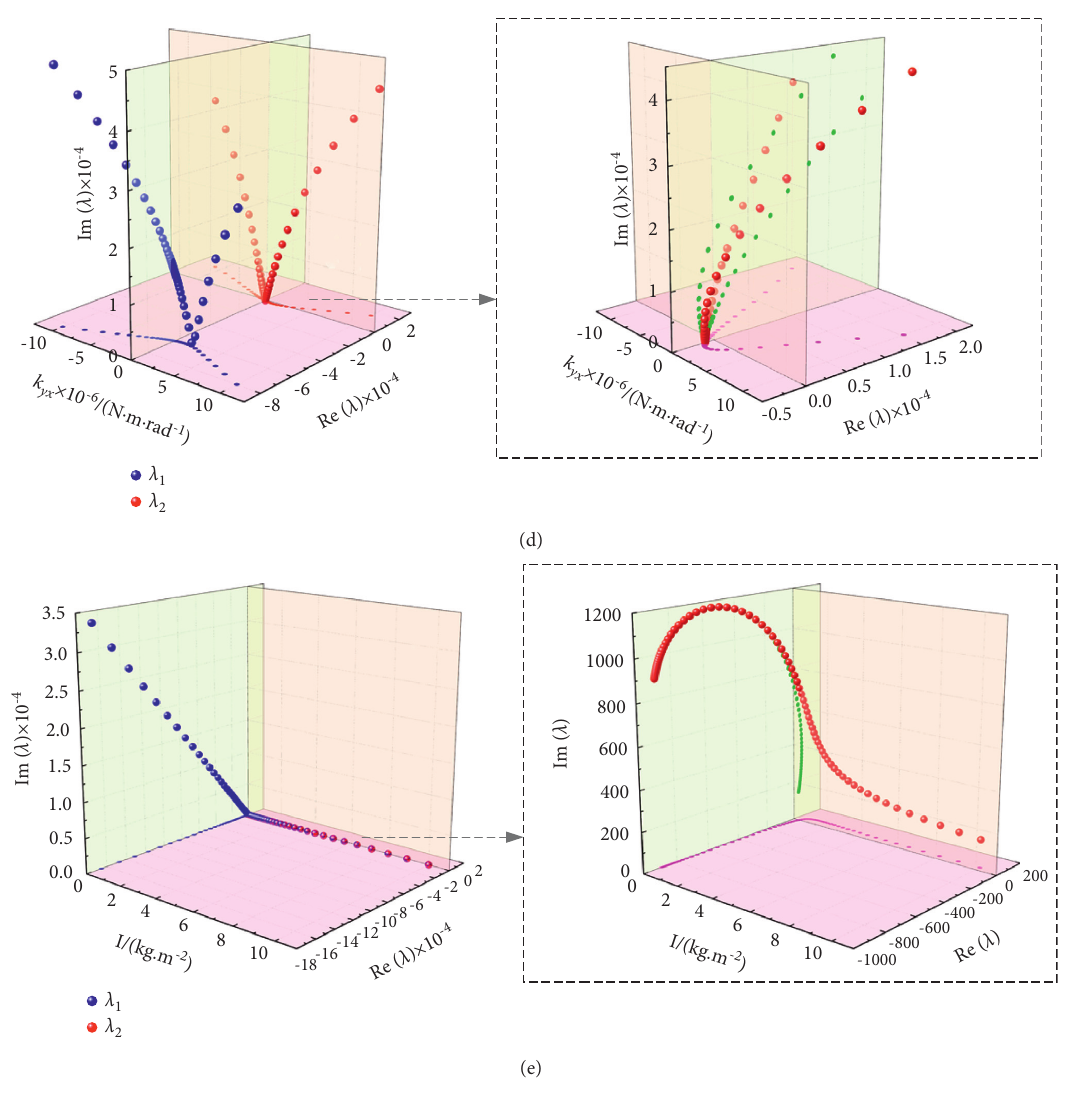
Figure 4: Root locus diagram under the influence of a single factor: (a) c